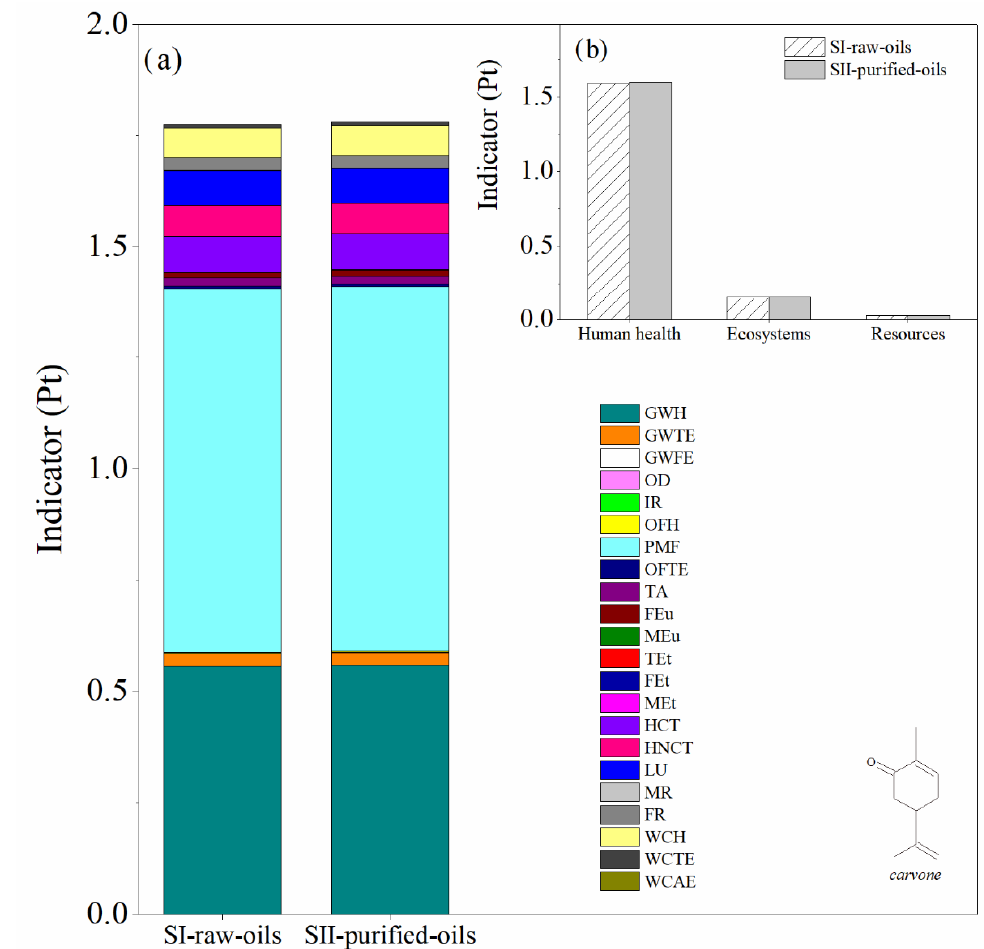
Figure 9. Comparison of the environmental impacts in the SI-raw-oils and SII-purified oils scenarios for the carvone process production. ( a ) Impact categories and ( b ) damage categories. Assessment method: ReCiPe 2016 Endpoint (H) V1.04/World (2010) H/A.